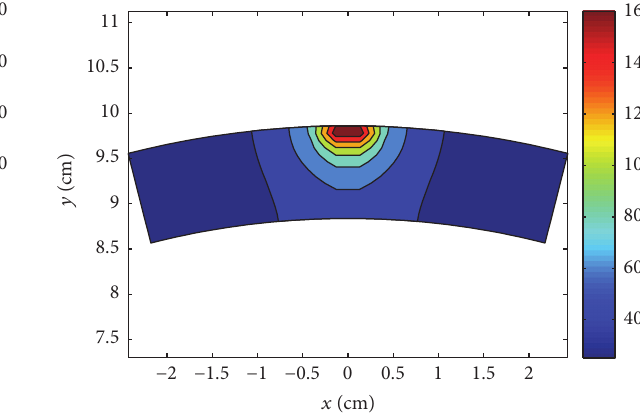
Figure 8: Temperature distribution at 𝑡 𝑓 = 3 min.